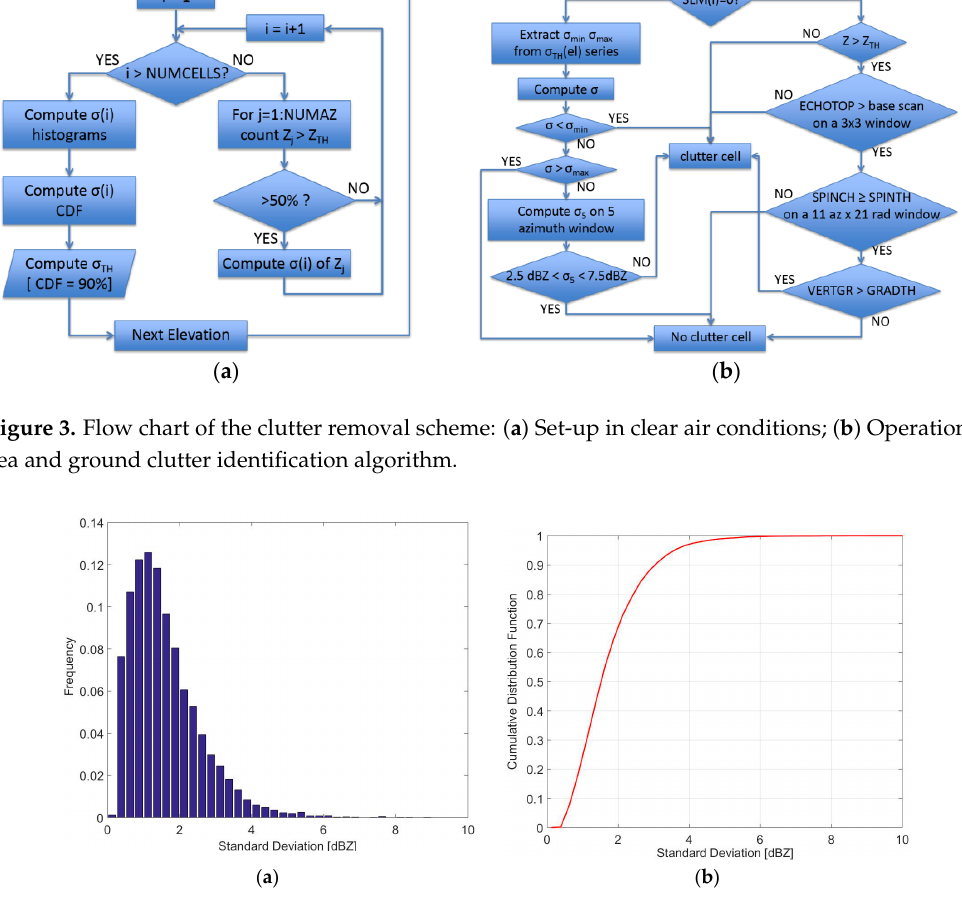
Figure 4. Example of values computed during clear air conditions for the 5 February 2016, 15:00 UTC: ( a ) Histogram of standard deviation of reflectivity for 1° cells; ( b ) Resulting cumulative distribution function.